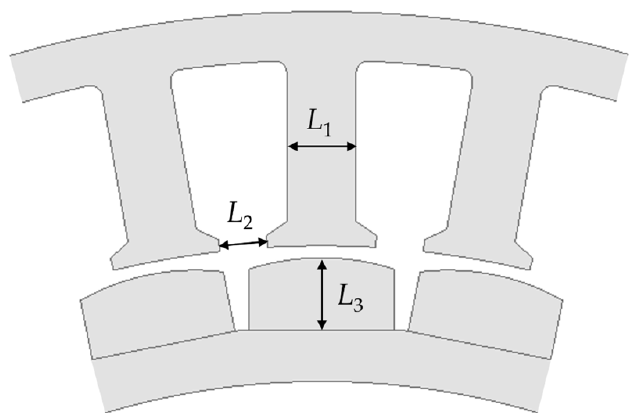
Figure 2. Diagram of key dimensions.